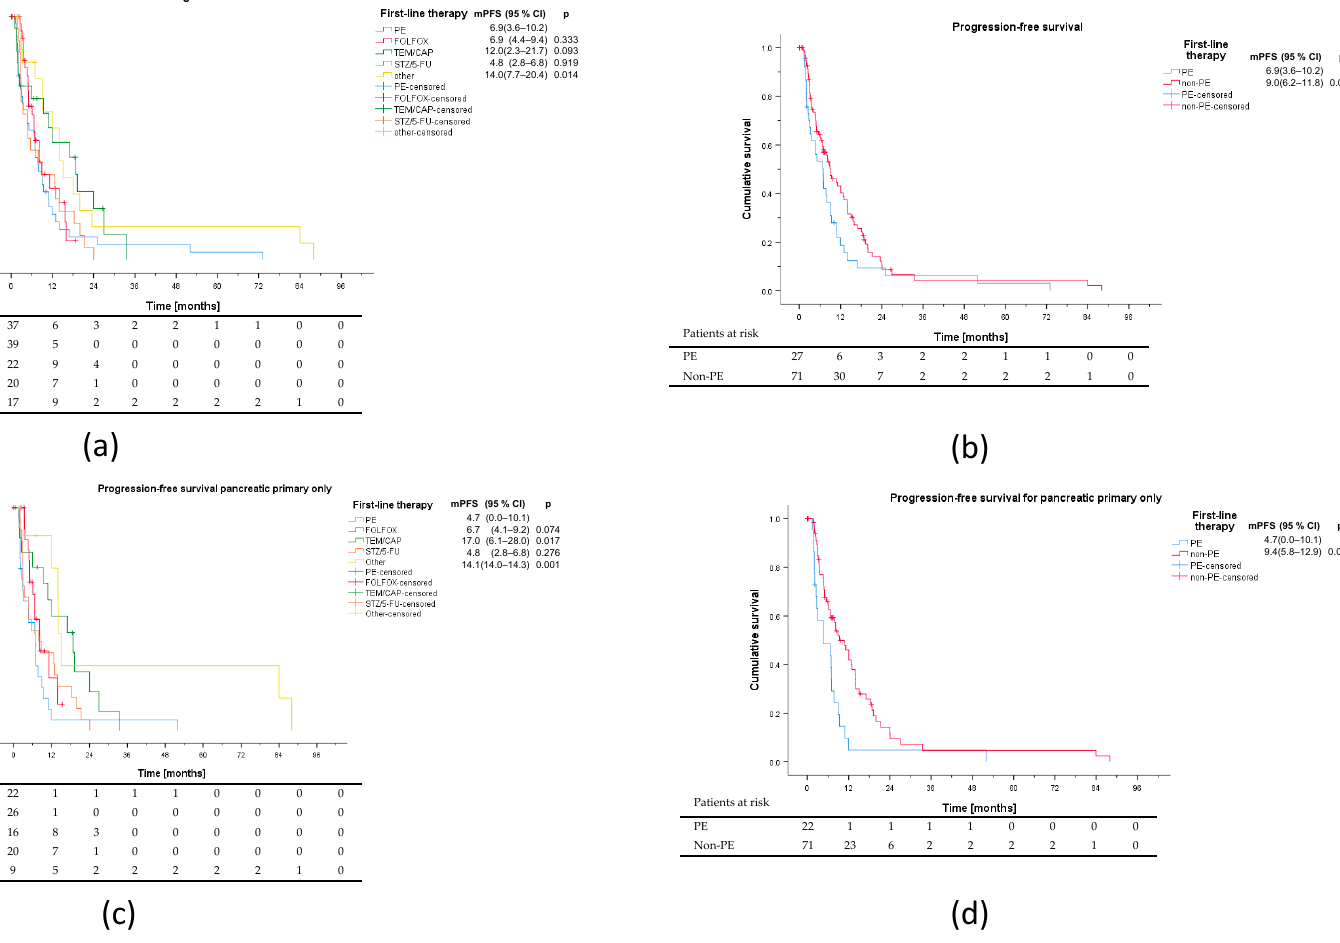
Figure 2. Progression-free survival of different first-line regimens. Patients receiving SSAs, PRRT, other chemotherapeutic regimens, targeted agents and multimodal combination approaches were subsumed under other. Median PFS is listed with 95% confidence intervals. All p values are delineated in comparison to platinum + etoposide (PE). ( a ) Comparison of the main treatment groups. ( b ) Comparison of PE vs. non-PE. ( c ) Comparison of the main treatment groups for pancreatic primary only. ( d ) Comparison of PE vs. non-PE for pancreatic primary